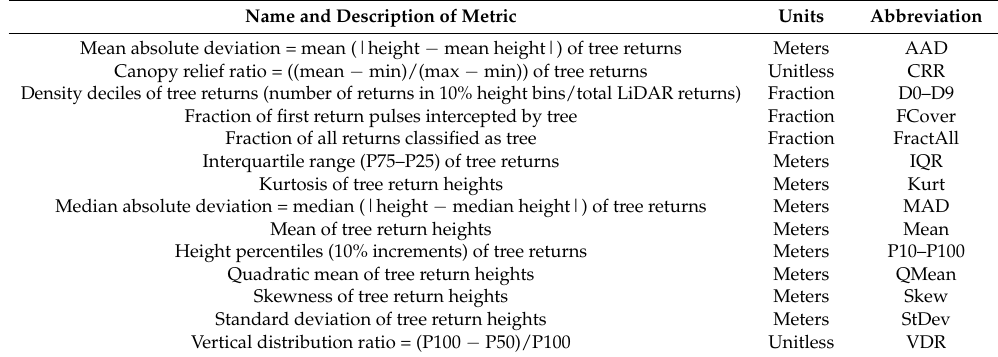
Table 1. Full list of light detection and ranging (LiDAR) metrics and abbreviations.